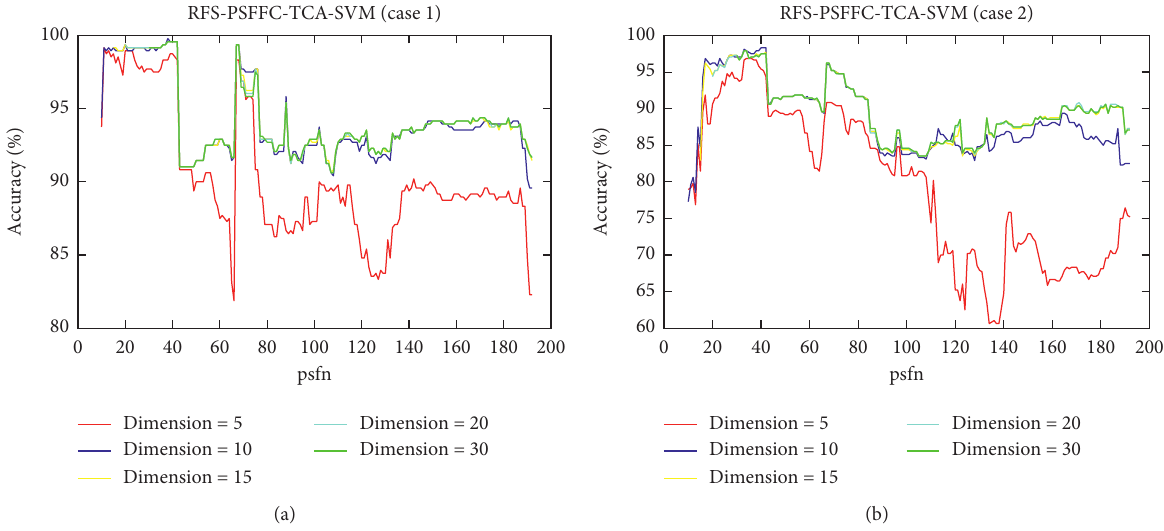
Figure 18: The testing accuracies of RFS-PSFFC-TCA-SVM with different dimension sizes for TCA.